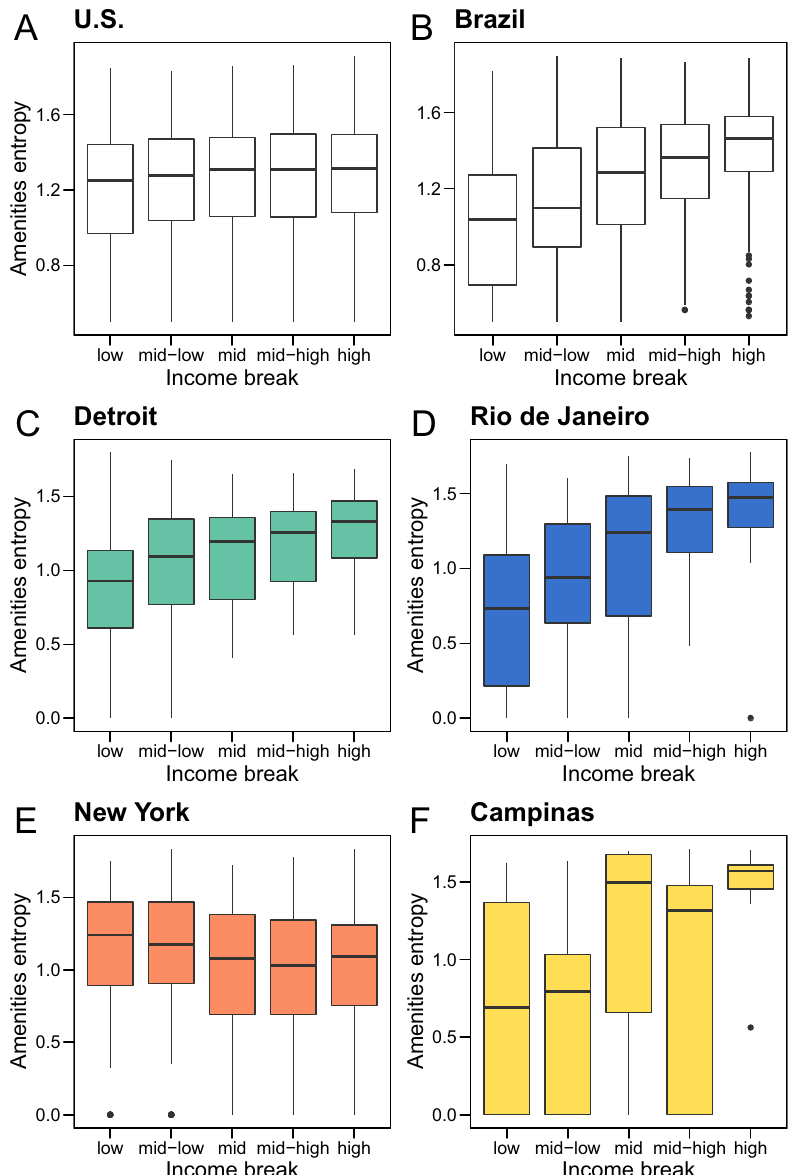
Figure 5. Diversity of urban amenities per median income quintile. Entropy of amenities in each of the sub- areas as a function of the median income in the United States ( A ) and Brazil ( B ). Entropy of amenities in each of the sub-areas as a function of the income in Detroit ( C ), a typical city of the teal cluster in the United States. Areas with higher median income tend also to have a higher diversity of amenities, a similar pattern seen for Rio de Janeiro ( D ) a typical city of the blue cluster in Brazil. In New York City, NY ( E ) (orange cluster), the trends are flat, and in Campinas ( F ) noisy, though higher-income areas on average, have higher amenity